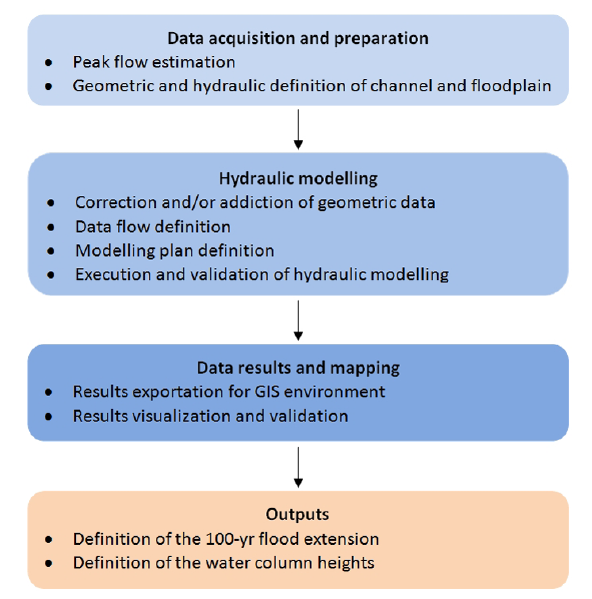
Fig. 5. Methodological approach for the hydrological-hydraulic